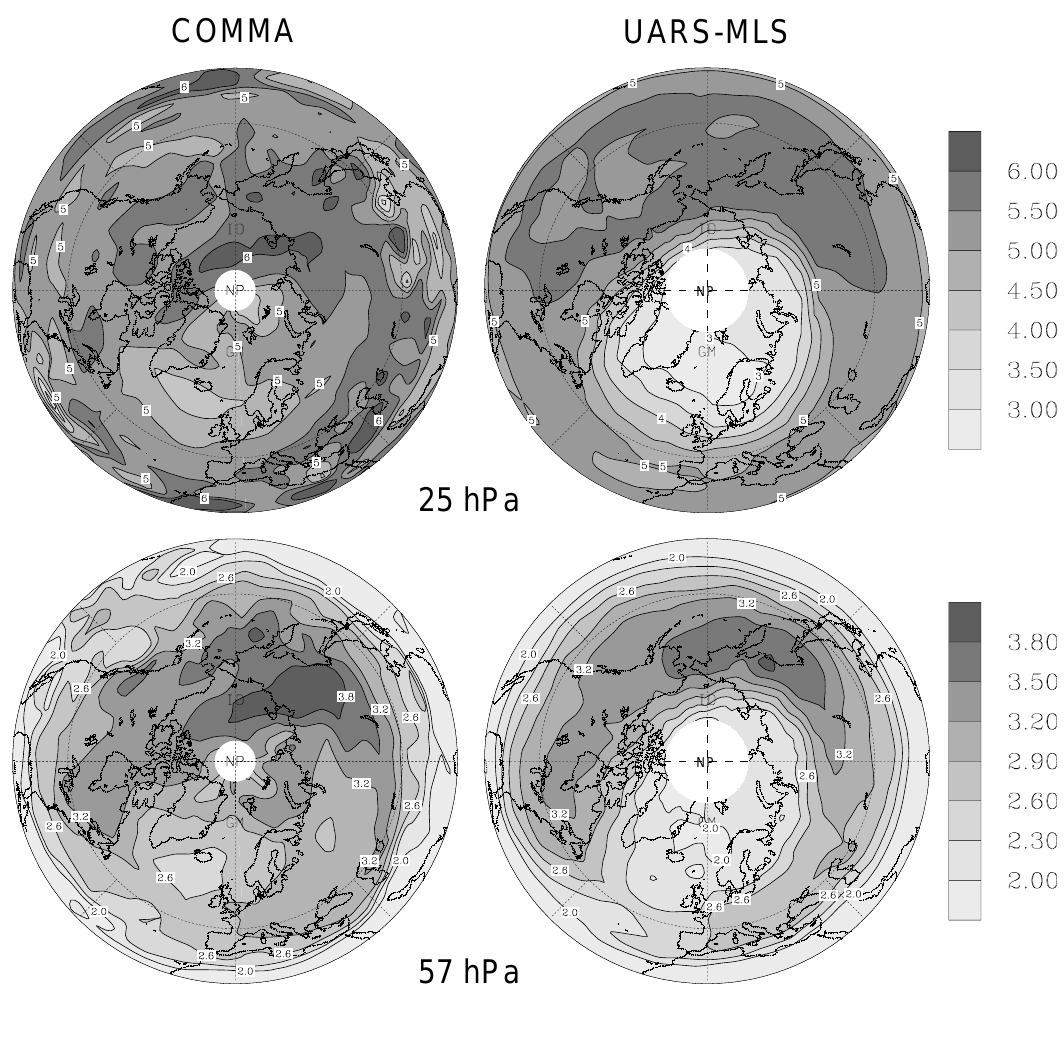
Fig. 8. Temporal mean ozone mixing ratio (ppmv) of the period between 13 and 20 February 1996, (left) calculated from the simulation using the STS/NAT-scheme and (right) derived from UARS-MLS data. Horizontal distributions are shown for (top frames) 25 hPa and (bottom frames) 57